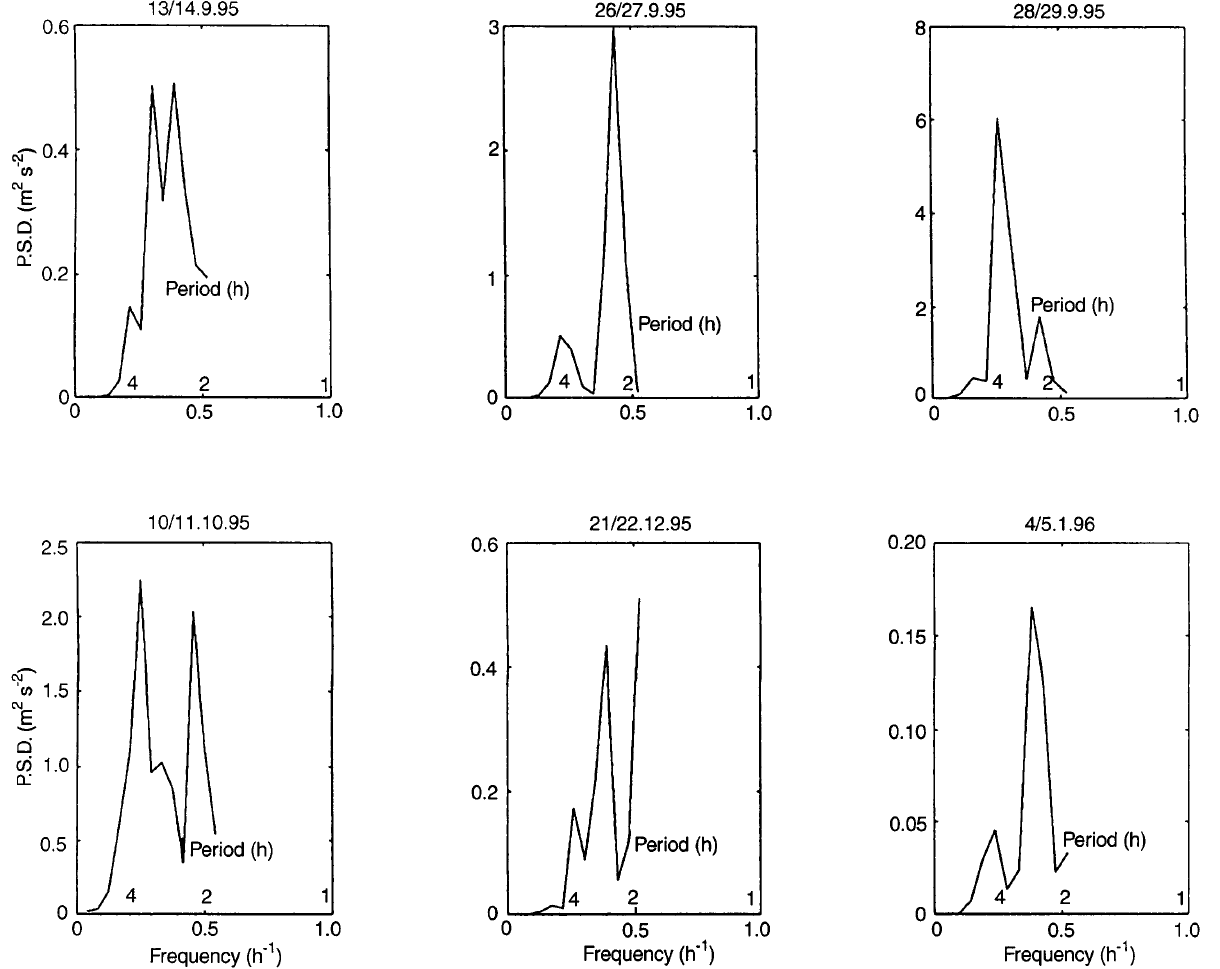
Fig. 4. Frequency spectra of zonal winds at 15 km on